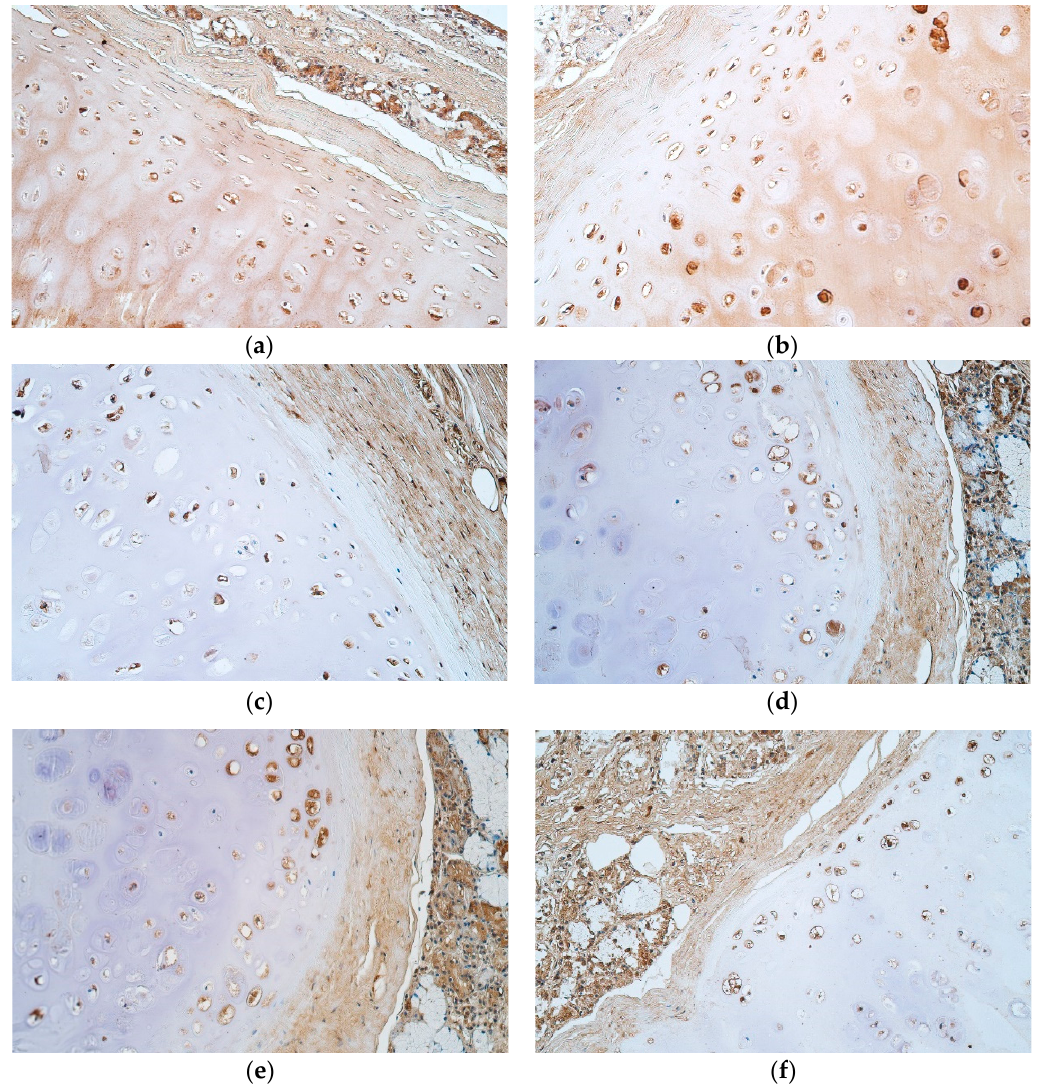
Figure 3. ( a – f ) Immunohistochemical micrographs of tracheal hyaline cartilage: ( a ) Moderate number of HBD-2 positive cells across proliferation and growth zones. HBD-2 IMH, ×200; ( b ) HBD-2 positive cells in moderate number across the proliferation zone with numerous positive cells in the growth zone. HBD-2 IMH, ×200; ( c ) Moderate number of HBD-3 positive cells in the growth zone with only few positive cells in the mature cell zone. HBD-3 IMH, ×200; ( d ) Note the moderate amount of HBD-3 positive cells in the proliferation and growth zones with only few positive cells in the mature cell zone. HBD-3 IMH, ×200; ( e ) Moderate amount of HBD-4 positive cells in the proliferation and growth zones with only few positive cells in the mature cell zone. HBD-4 IMH, ×200; ( f ) HBD-4 positive cells in moderate number throughout proliferation and growth zones with few positive cells in the mature cell zone. HBD-4 IMH, ×200.